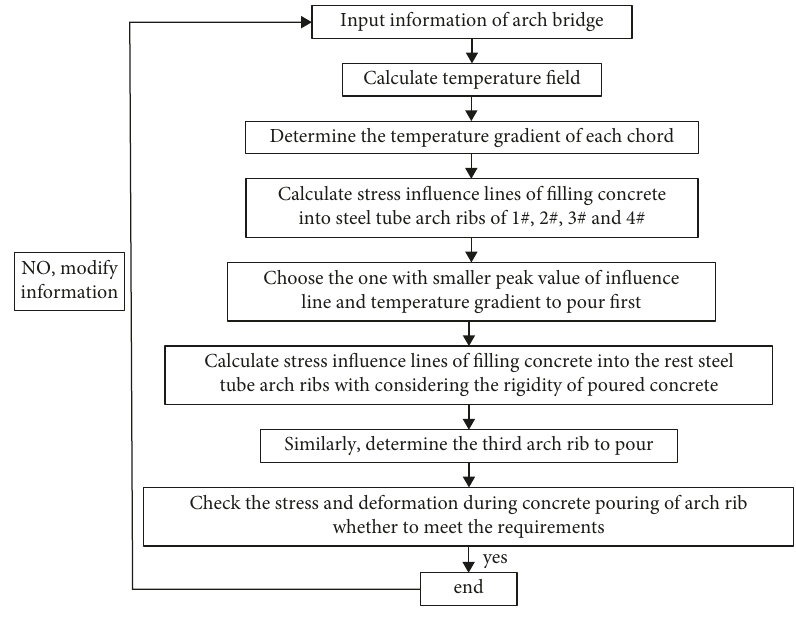
Figure 19: The calculation flowchart of transverse perfusion